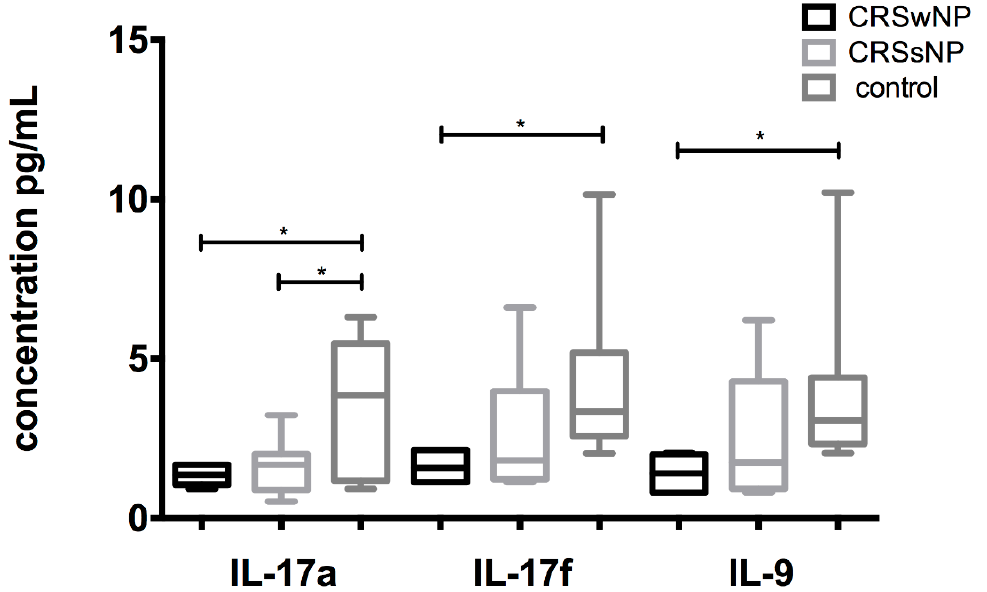
Figure 4. Comparison of IL-17a, IL-17f, and IL-9 secretion between patients with CRSwNP, CRSsNP, and healthy individuals: A significantly higher secretion of IL-17f and IL-9 was found in the supernatant in the local CD8+ T cells from the healthy controls in comparison to the local CD8+ T cells from CRSwNP patients. A higher concentration of IL-17a was found in the healthy controls in comparison to both subtypes of CRS. * p < 0.05.